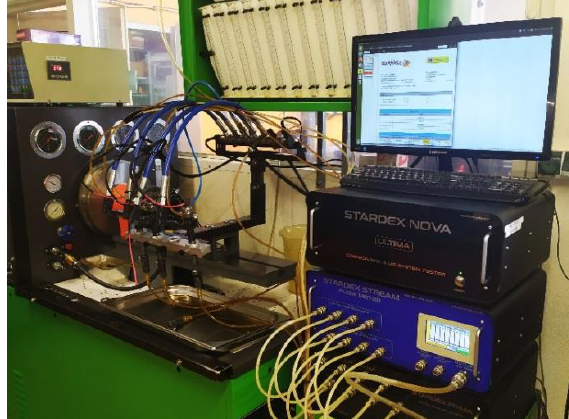
Fig. 2. 12PSB test bench with Stardex kit